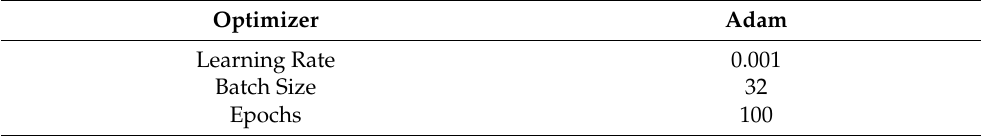
Table 4. Hyperparameters for training the Convolutional Neural Networks